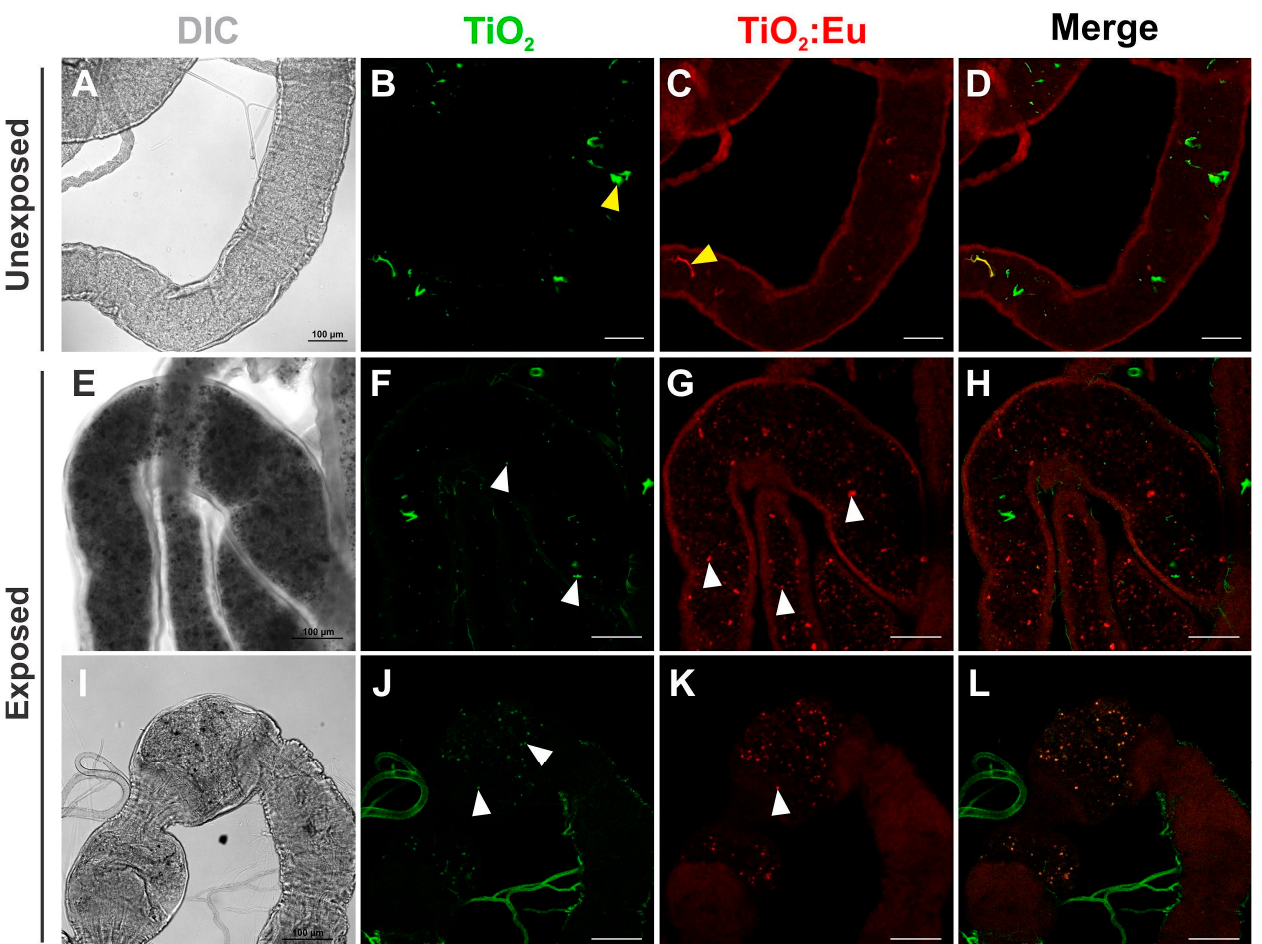
Figure 3. Confocal images of the distribution of TiO 2 and Eu 3+ -doped TiO 2 nanocrystals in the Drosophila third instar larval gut. ( A – D ) Gut dissected from unexposed third instar larvae fed in standard food medium showing autofluorescence of the food. ( E – L ) Gut dissected from third instar larvae exposed to 4 mg/mL of TiO 2 and Eu 3+ -doped TiO 2 showed nanocrystals dispersed along the lumen of the midgut ( E – H ) and the foregut ( I – L ). DIC: differential interference contrast; Green: TiO 2 nanocrystals fluorescence under 405 nm excitation; Red: Eu 3+ -doped TiO 2 nanocrystals fluorescence under 552 nm excitation. Yellow arrowheads in ( B ) and ( C ) represent autofluorescent cornmeal found in standard Drosophila media and white arrowheads in ( F , G , J , K ) indicate nanocrystal aggregates. Scale bars = 100 μ m.